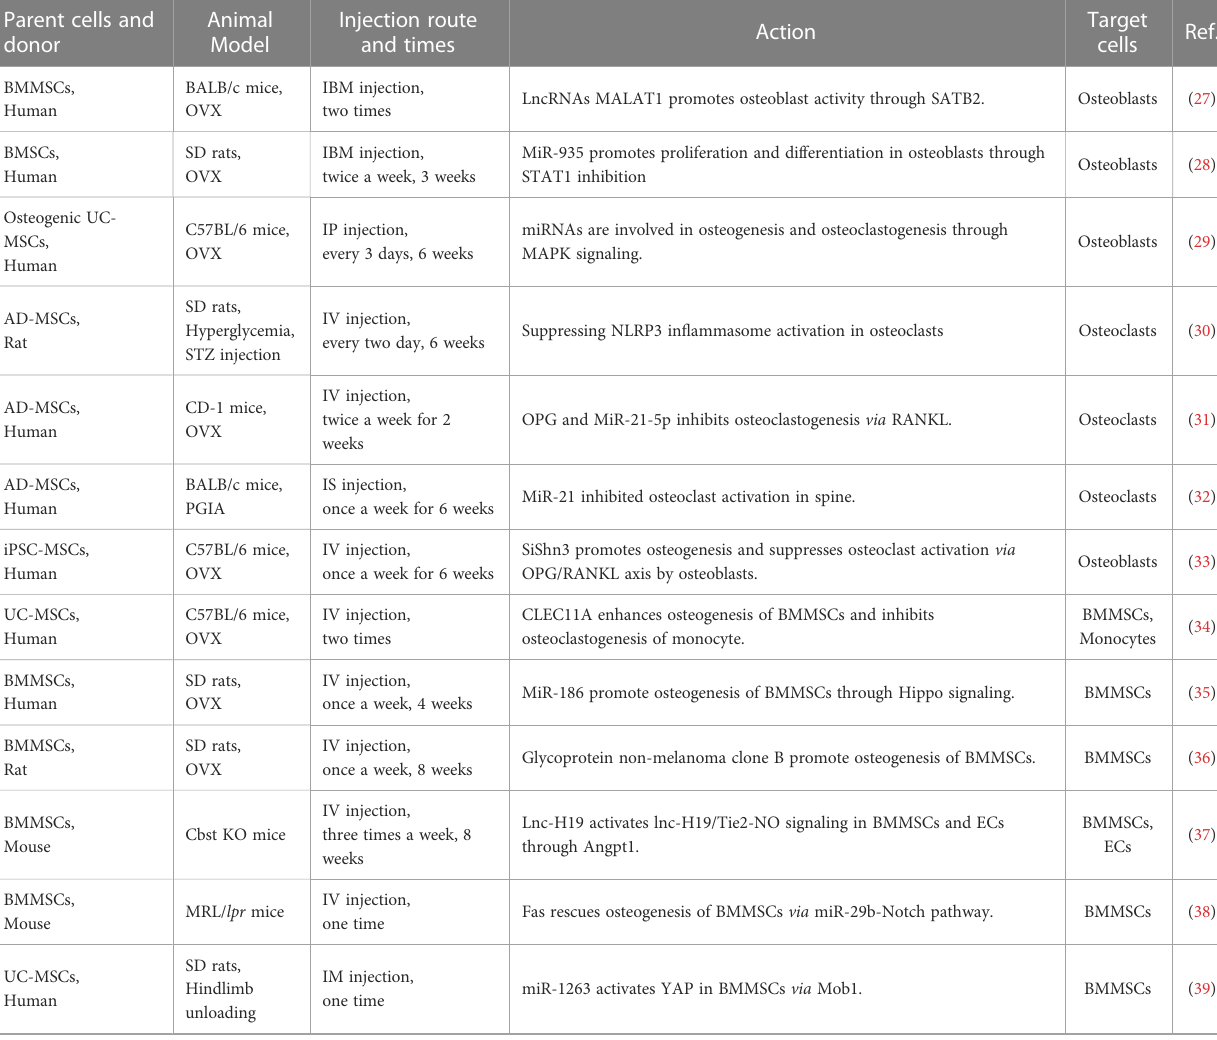
TABLE 1 Summary of parent cell origins, animal models, route and times of injection, actions, and target cells of MSC-derived extracellular vesicle therapy for osteopenia. Parent cells and